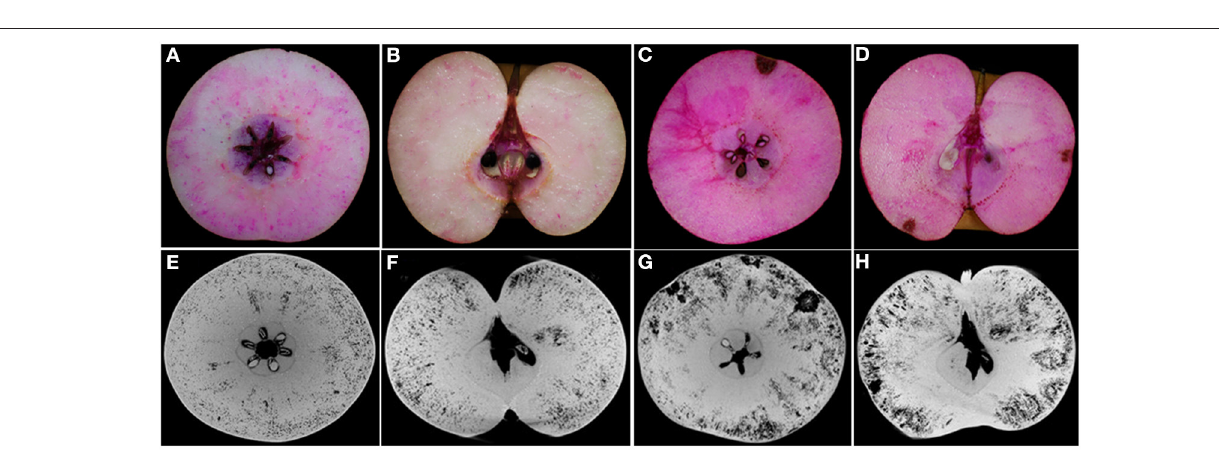
FIGURE 2 | Observation of cork spot distribution in “Akizuki” fruit at harvesttime. (A,B) Transverse and longitudinal sections of healthy fruit stained by safranine solution, respectively. (C,D) Transverse and longitudinal sections of cork spotted fruit stained by safranine solution, respectively. (E,F) Transverse and longitudinal segments of healthy fruit extracted from the X-ray scanning data, respectively. (G,H) Transverse and longitudinal segments of cork spotted fruit extracted from the X-ray scanning data,